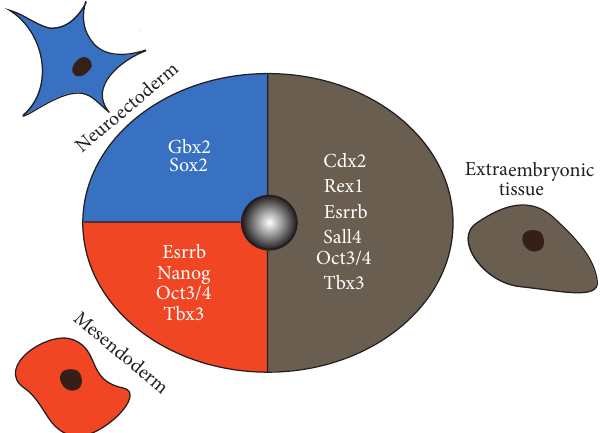
Figure 3: Spatial classifications of pluripotency factors. Upon exit of pluripotency core pluripotency factors get committed to distinct lineages and arising tissues, thus playing a crucial role in directing early lineage decisions in mouse. This image illustrates their spatial classification in the early embryo: neuroectoderm is mainly pro- moted by Gbx2 and Sox2 and mesendoderm especially by Esrrb, Nanog, Oct3/4, and Tbx3. Further, the extraembryonic tissue is induced by Cdx2, Rex1, Esrrb, Sall4, Oct3/4, and Tbx3. Cdx2: caudal type homeobox 2, Esrrb: estrogen-related receptor 𝛽 , Gbx2: gas- trulation brain homeobox 2, Tbx3: T-box transcription factor 3, Oct3/4: octamer binding transcription factor 3/4, Rex1: Zfp42, Sall4: Sal-like 4, and Sox2: SRY- (sex determining region Y-) box